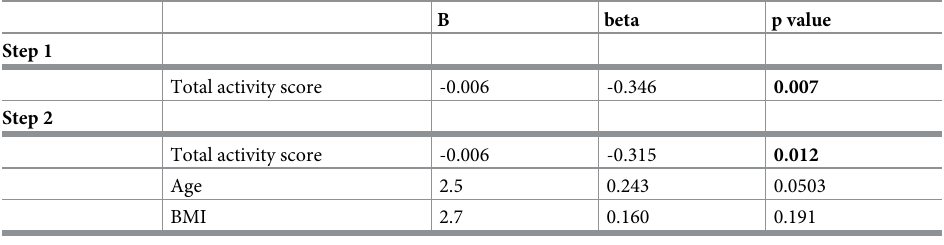
Table 4. Simple and multiple linear regression models for peak postoperative C-reactive protein (n =